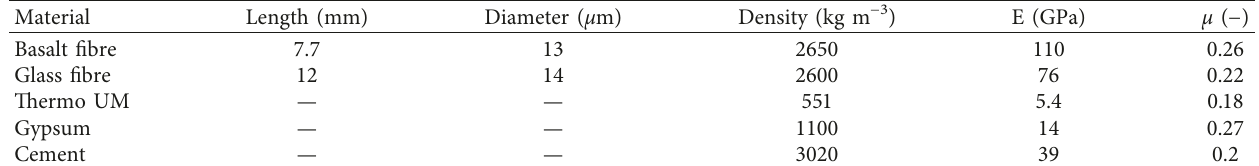
Table 1: Mechanical properties of the base